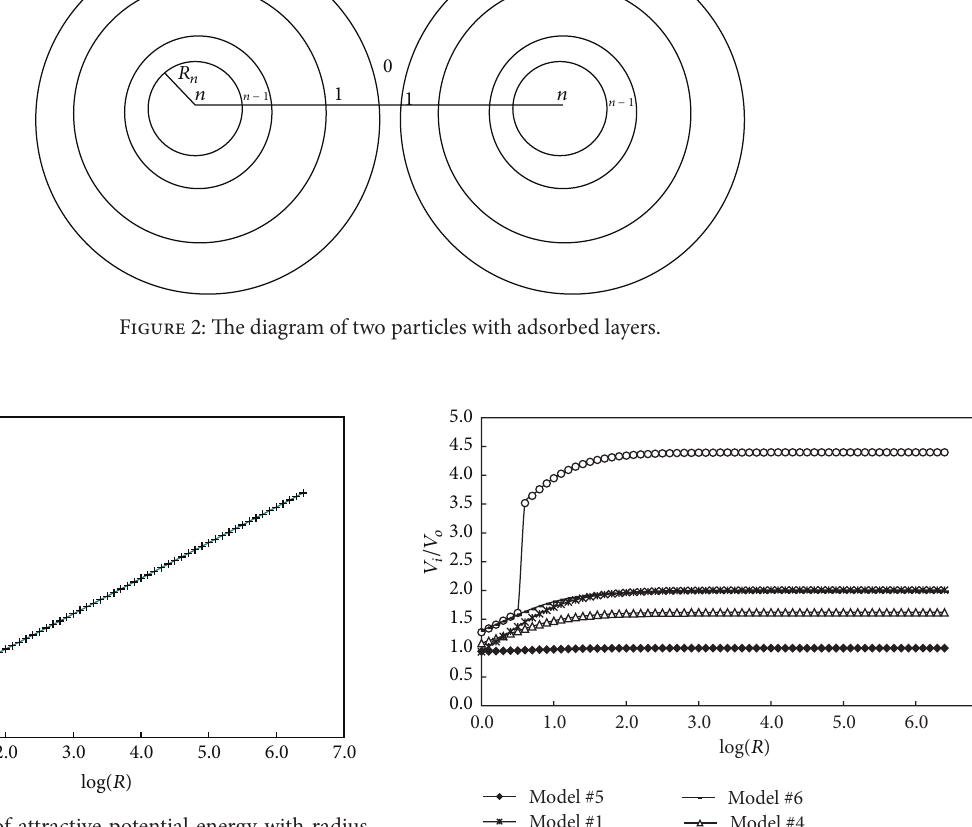
Figure 3: The variation of attractive potential energy with radius values of TH-AR for model #7.